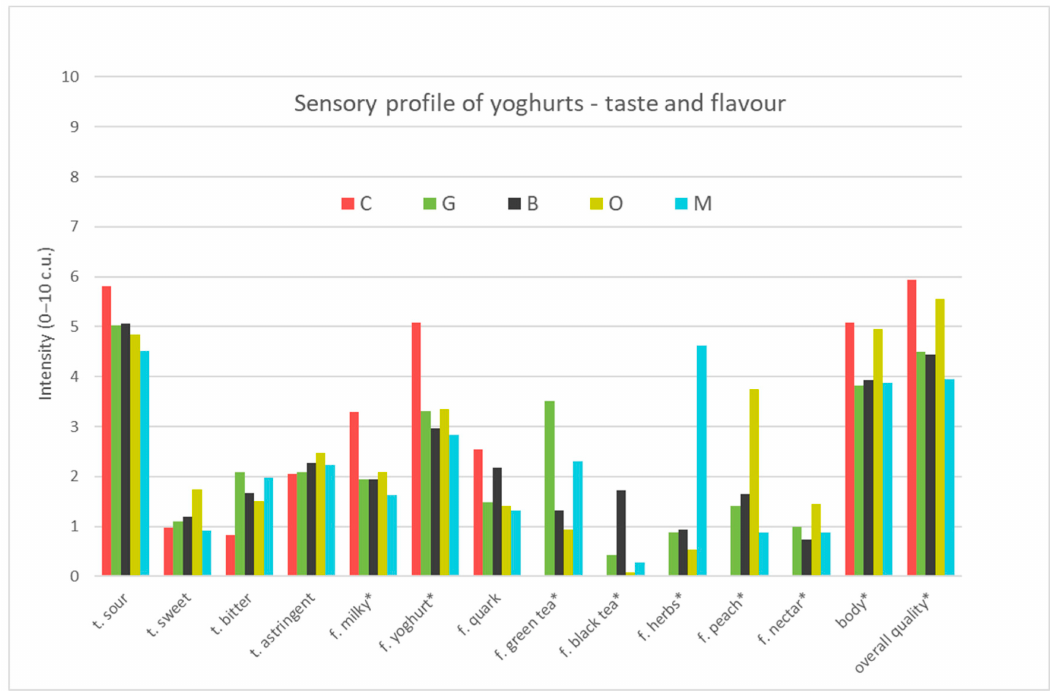
Figure 3. The sensory quality profile of yoghurt samples (appearance and texture). C—Control, G—Green tea, B—Black tea, O—Oolong tea, M—Lemon balm (*—di ff er significantly p ≤ 0.05).